Question: Describe this figure in one sentence.
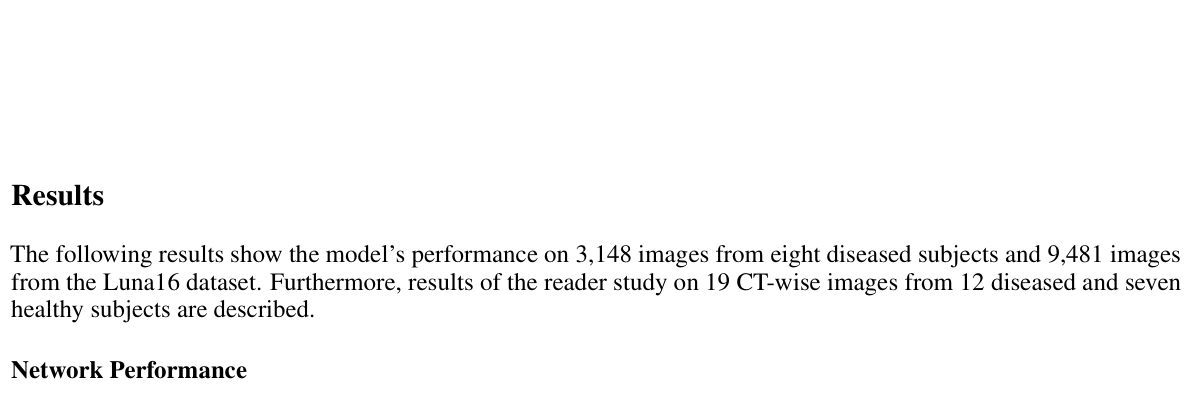
Answer: shows an example slice with varying levels of subsampling alongside the corresponding U-Net postprocessed results. It can be observed that fewer projection views result in more artifacts. The sparse-view images from extremely limited views also lead to a loss of structural integrity in their postprocessed counterparts. This was especially prominent for 16 views, as metastatic lung nodule distortion and microvascular structures generate diminished performance capabilities. metastatic nodule composition and primary anatomical characteristics can better be amassed once reconstruction views have increased to 32. For 64 views, streak artifacts did not impact the nodule’s visibility due to tissue density, but minimalistic structural identification, such as small vessels, are not clearly portrayed. Minor features were displayed for 128 and 256 views; however, for 128 views, some streak artifacts remained present. For the postprocessed image of 32 views, the nodule shape was mostly corr